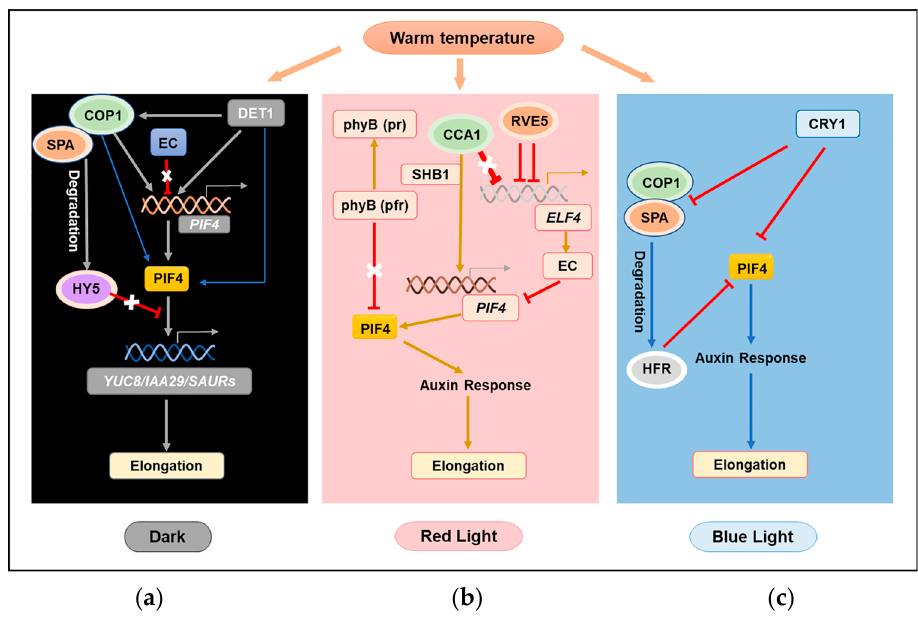
Figure 4. Schematic representation of PIF4-mediated integration of the light signal with the warm temperature signal in plants. PIF4 acts as a cellular “hub” for this integration involving photoreceptors and influences the morphogenic changes by mediating the auxin response in response to a combination of moderately elevated ambient temperature and different light signals. ( a ) PIF4 integrates the darkness signal with the elevated temperature signal and promotes hypocotyl elongation; ( b ) PIF4 integrates the red light signal with the elevated temperature signal and promotes hypocotyl elongation; ( c ) PIF4 integrates the blue light signal with the elevated temperature signal and inhibits hypocotyl elongation.